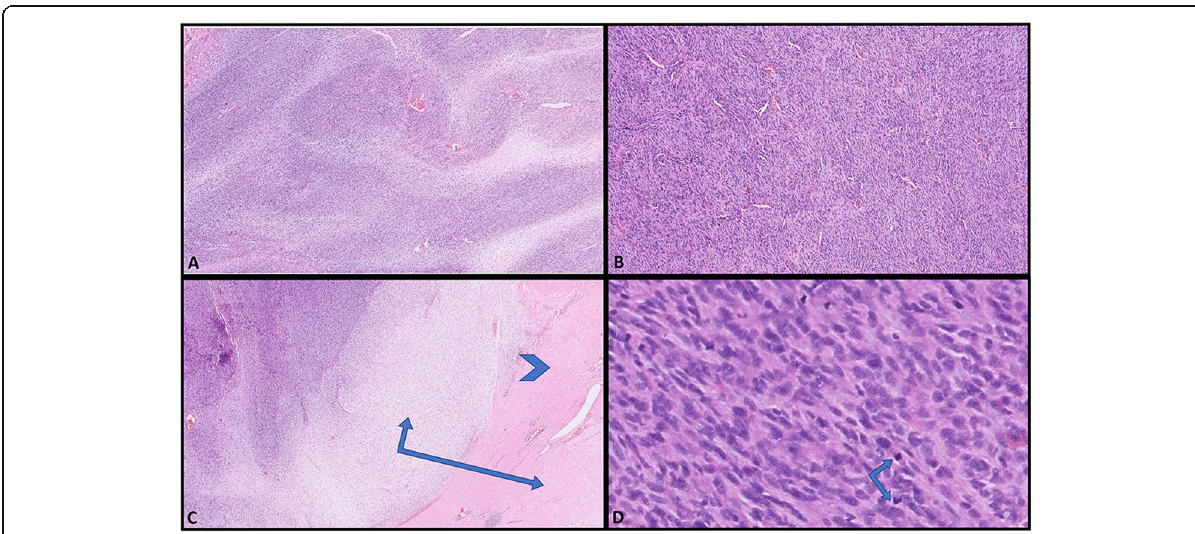
Fig. 2 Histological examination shows variable cellular spindle cell tumour ( A H&E; 40x) with prominent hemangiopericytomatous vasculature pattern(( B H&E; 100x) and areas of necrosis [double arrowhead] and sclerotic bands ( C H&E; 100x). The tumour cells revealed marked nuclear atypia, hypercellularity and brisk mitosis (arrow) ( D H&E; 400x)